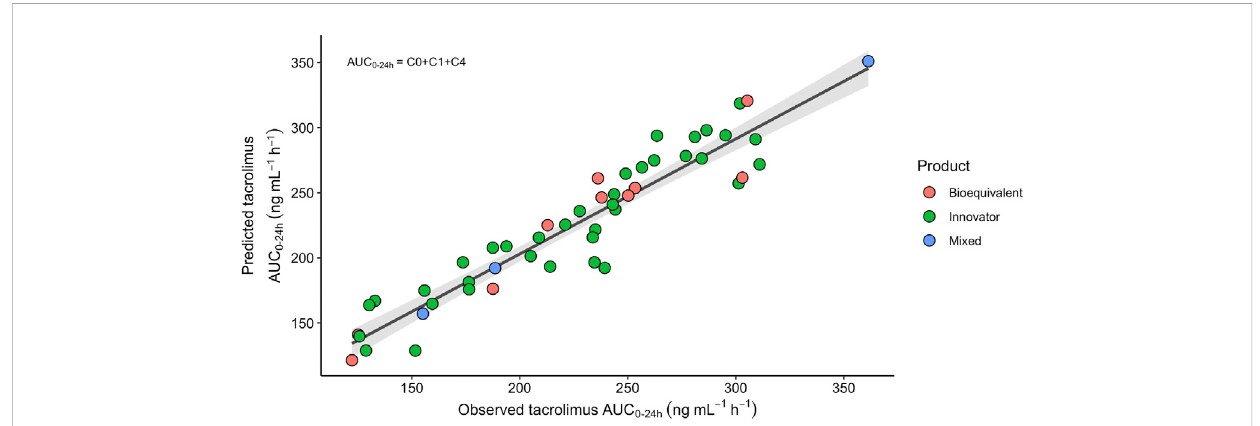
FIGURE 3 Relationship between the TAC observed trapezoidal and predicted AUC (0 – 24) according to the equation LSS-AUC (0 – 24) = 26.0 +